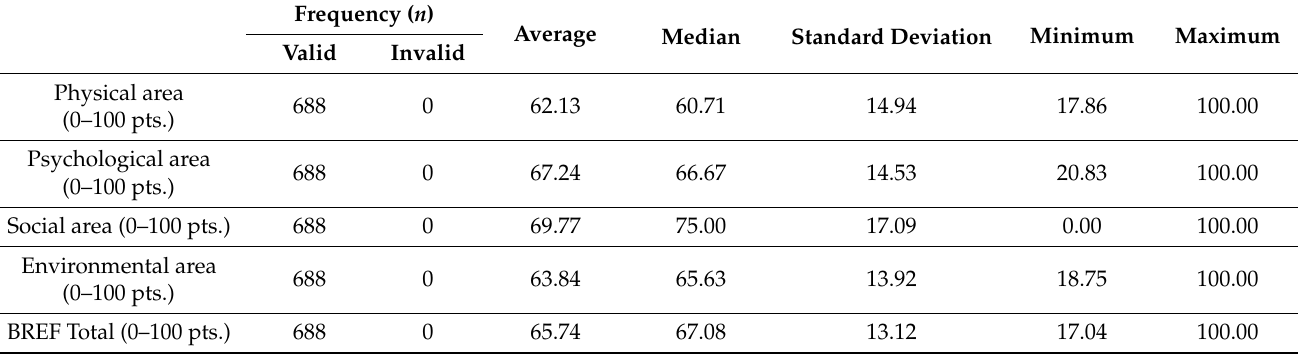
Table 3. Mean scores of WHOQOL-BREF quality of life scale of surveyed